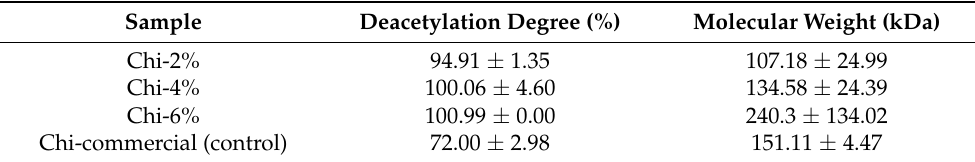
Table 2. Molecular weight and deacetylation degree of chitosan extracted from P. magdalenae